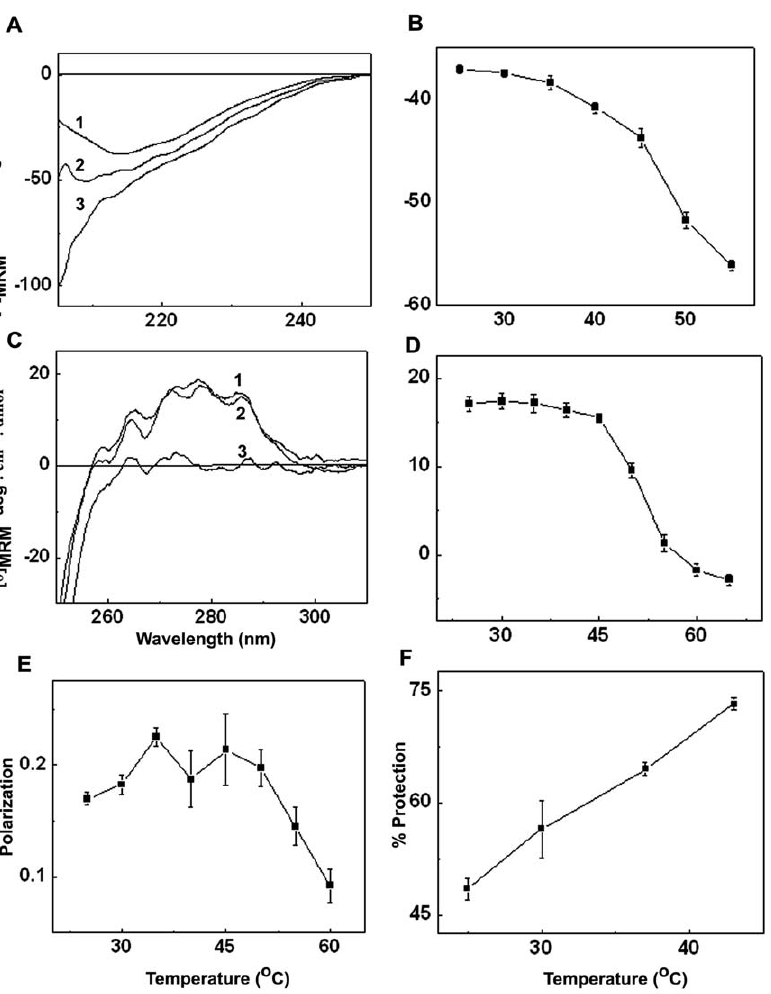
Figure 10. Temperature-induced changes in the conformation and chaperone property of HspB2. (A) far UV-CD spectra of HspB2 at 25 u C (1), 45 u C (2) and 55 u C (3). (B) The change in the mean residue mass ellipticity ([ h ]MRM) at 214nm as a function of temperature. (C) Near UV-CD spectra of HspB2 at 25 u C (1), 45 u C (2) and 55 u C (3). (D) The change in the [ h ]MRM at 286 nm as a function of temperature. (E) The changes in the fluorescence polarization of AIAS-labelled HspB2 with increasing temperature. (F) % Protection offered by HspB2 to the DTT-induced aggregation of insulin at different temperatures.